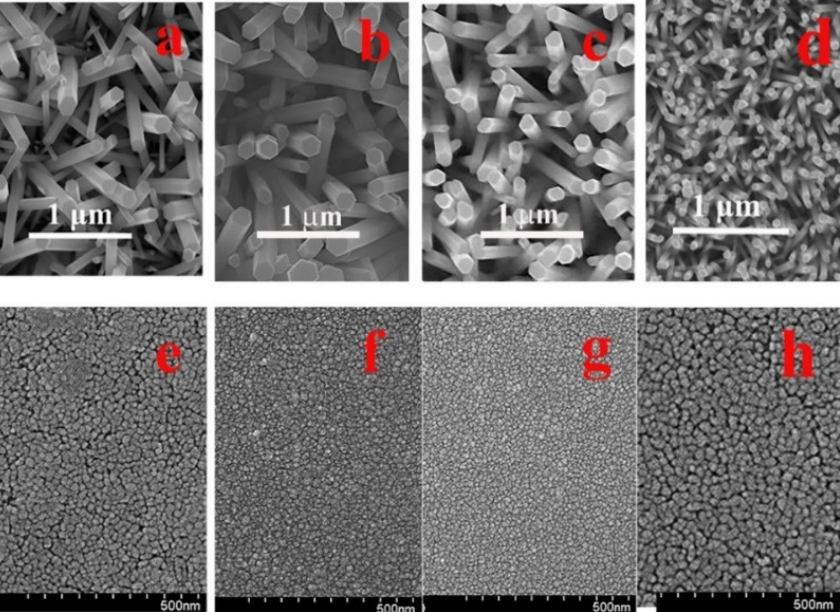
Figure 2. Cross-sectional SEM views of the NRs grown on the as-coated SLs preheated at 100 °C ( a ), 200 °C ( b ), and 300 °C ( c ) and O 2 -plasma-treated SLs (PH at 100 °C) ( d ). Plane-view SEM micro- graphs of the ZnO SLs preheated at 100 °C ( e ), 200 °C ( f ), and 300 °C ( g ) and O 2 -plasma-treated SLs (PH at 100 °C) ( h ).